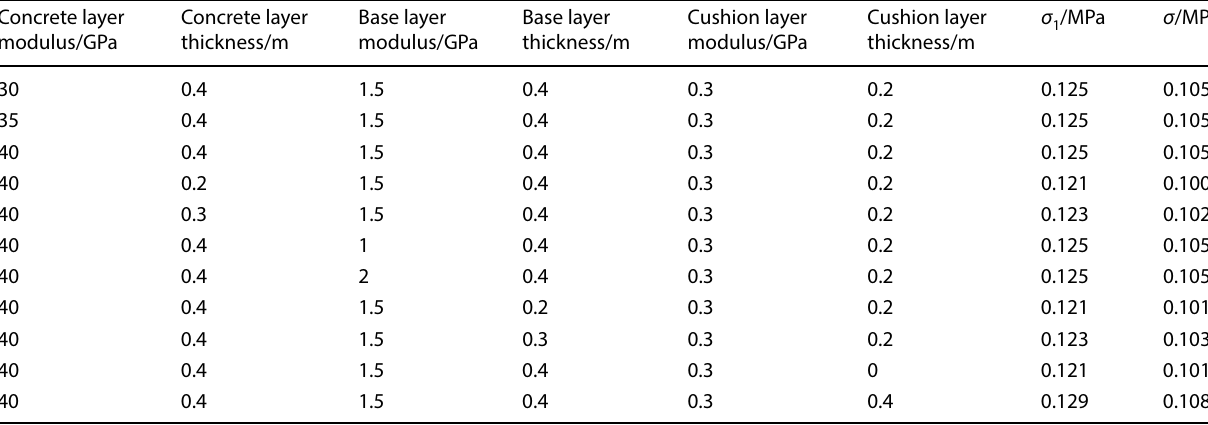
Table 4 Stress level of the subgrade (5.0 m away from the top of the subgrade) Concrete layer